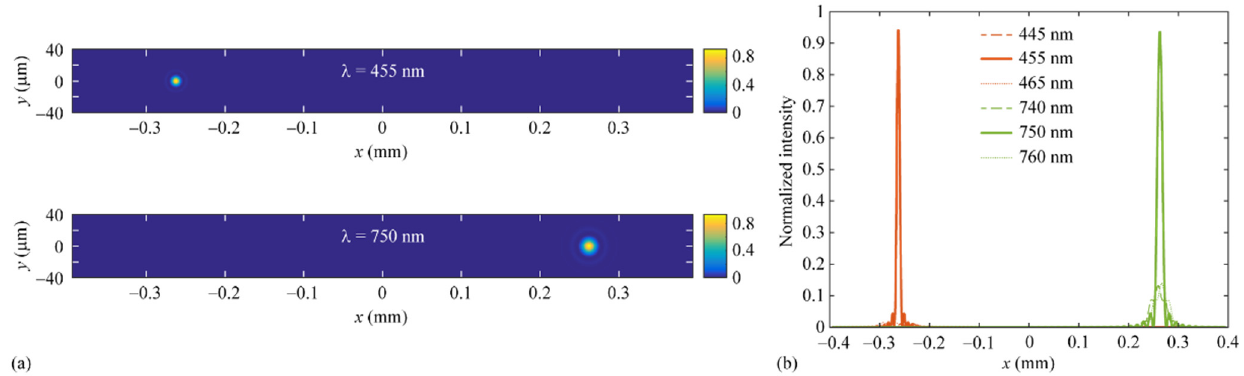
Figure 2. ( a ) Normalized two-dimensional intensity distributions generated by the calculated MWDL at the design wavelengths λ 1 = 455 nm (top) and λ 2 = 750 nm (bottom); ( b ) Cross-sections of the normalized intensity distributions along the x axis for the wavelengths λ 1 , λ 1 ± 10nm and λ 2 , λ 2 ± 10